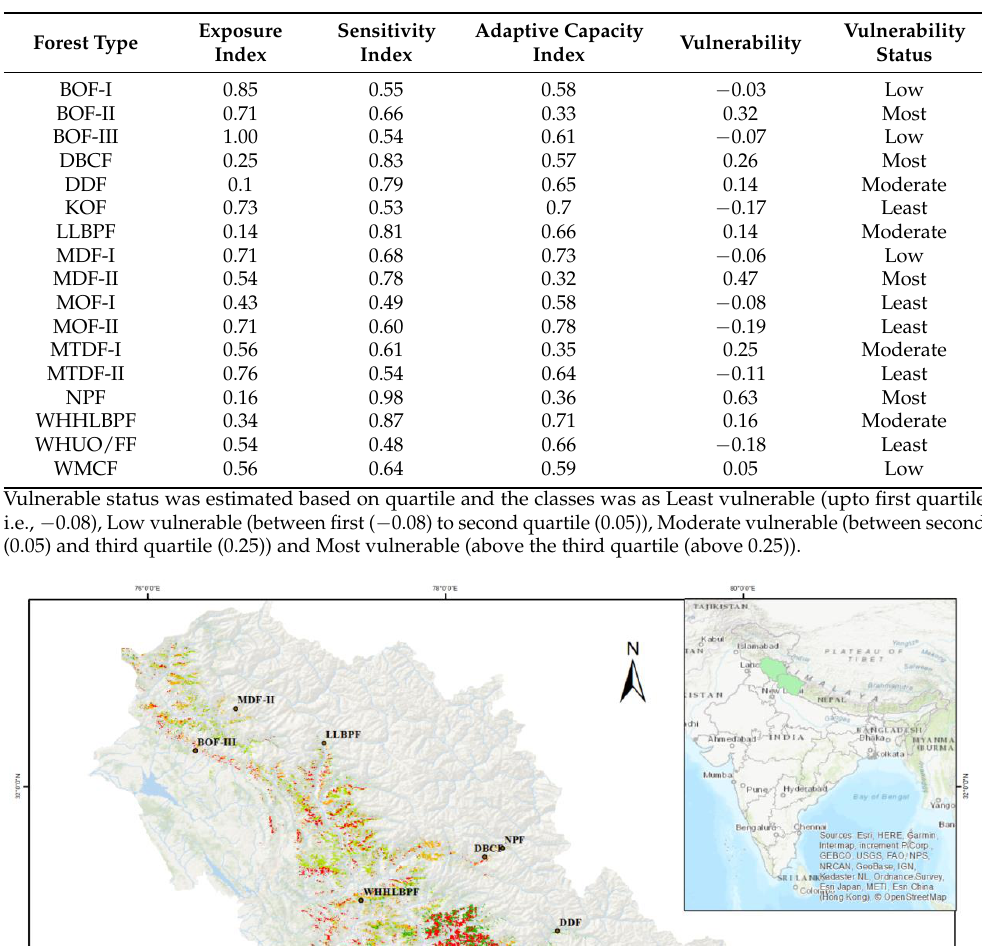
Table 2. Vulnerability status of different Himalayan temperate forests.